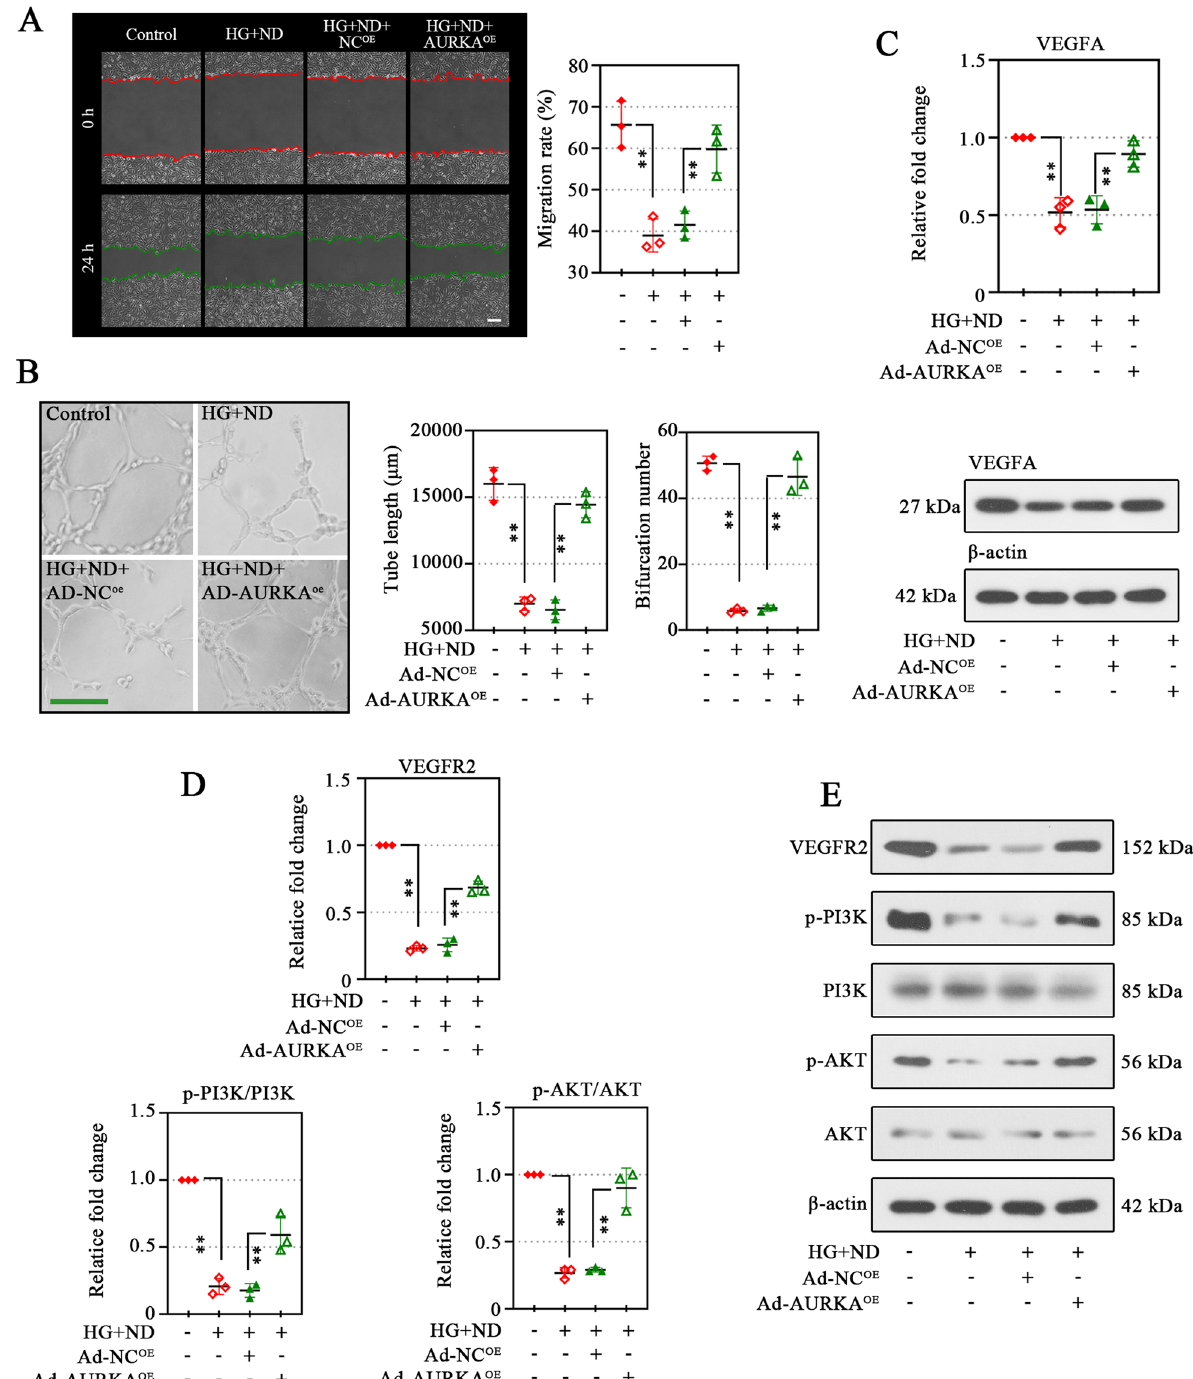
Fig. 3 Overexpression of AURKA exerts a promoting effect on migration and tube formation ability of microvascular endothelial cells. The migration of cells was analyzed by scratch assay (scale bar, 200 μm) ( A ), and the percentage of the scratch migration rate was shown on the right panel ( A ). Red and green line indicated the boundary lines of scratch ( A ). Tube formation assay ( B ) was conducted to measure the tube formation ability of HMEC-1 cells with AURAK overexpression, and the tube-like structure length and bifurcation point numbers were quantified as shown on the right. Western blot assay were used to detect the expression of vascular endothelial growth factor A (VEGFA) in HMEC-1 cells ( C ). Protein levels of Vascular Endothelial Growth Factor Receptor 2 (VEGFR2), phosphatidylinositol 4,5-Bisphosphate 3-Kinase (PI3K), phosphorylated (p)-PI3K, serine-threonine protein kinase (AKT), and p-AKT were analyzed using Western blotting ( D , E ). Data were represented as mean SD. ** P < 0.01. Each dot indicated a ± biological replicate, n =